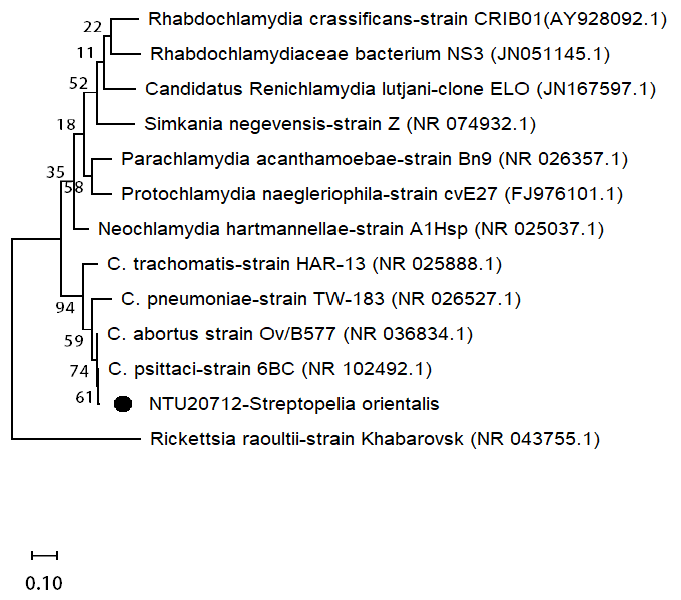
Figure 3. Phylogenetic analysis of Chlamydia psittaci based on sequences of the 16S rRNA gene. The black dot indicates the C. psittaci strain detected in the present outbreak. The GenBank accession numbers are shown in parentheses.